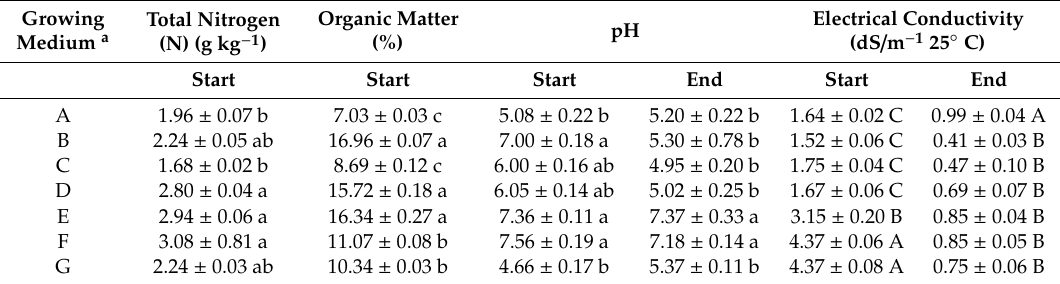
Table 1. Growing media chemical properties observed at the start (November 2013) and end (October 2015) of the trial. Values are means ( ± standard deviation). The b letter in a column indicate significant di ff erences (lowercase indicate p < 0.05, uppercase indicate p < 0.001) compared to the letter a and c based on Tukey’s honest significant di ff erence (HSD)